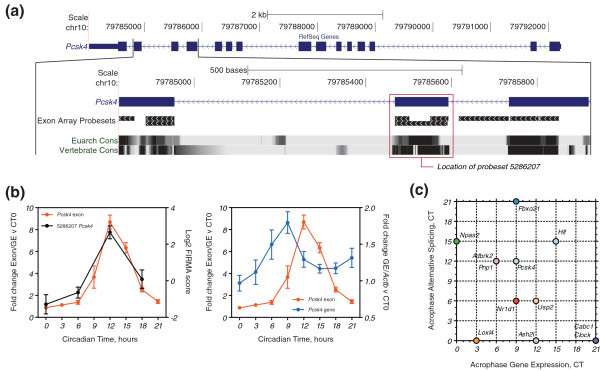
Validated circadian exons show a variety of acrophases in alternative splicing and transcript-level expression. (a) UCSC genome browser [73,79] screen-shots. Top: the structure of the Refseq mRNA and the location of the identified cassette exon for Pcsk4 (genome assembly mm9). Bottom: the closer genomic context of the identified exon, including the location of core exon-array probesets and phastCons conservation [80]. (b) Upper panel: plot of the log2 FIRMA score (black line, n = 3, standard error of the mean (SEM)) and alternative splicing (red line, n = 6, SEM) through time. Lower panel: plot of the alternative splicing (red line, n = 6, SEM) and transcript-level expression (blue line, n = 6, SEM) through time (GE, gene expression). (c) Scatter-plot relating the acrophase in transcript-level expression to the acrophase in alternative splicing for each of the validated exons. Acrophase is the circadian time of peak expression. Peak expression was defined as the circadian time of the largest positive fold change versus CT0. Decr1 is not included in this plot as its transcript-level expression was not rhythmic.